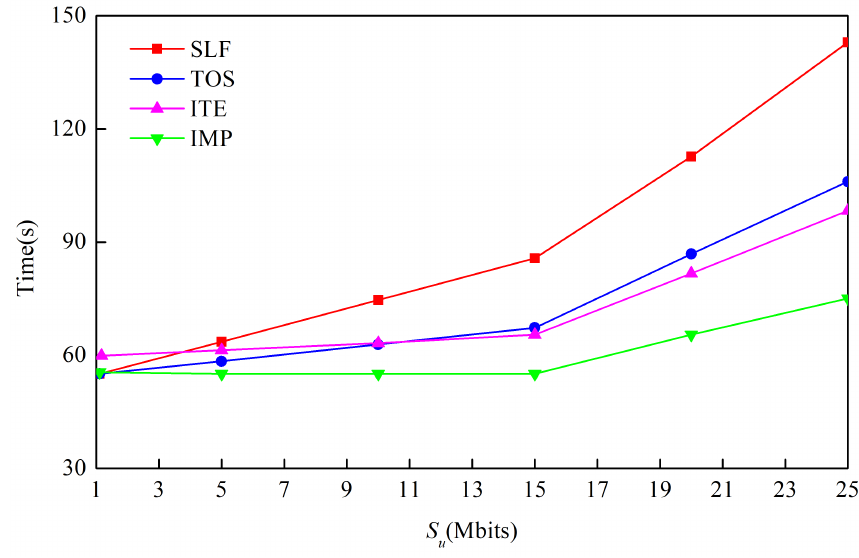
Figure 2. The relationship between task completion time and data